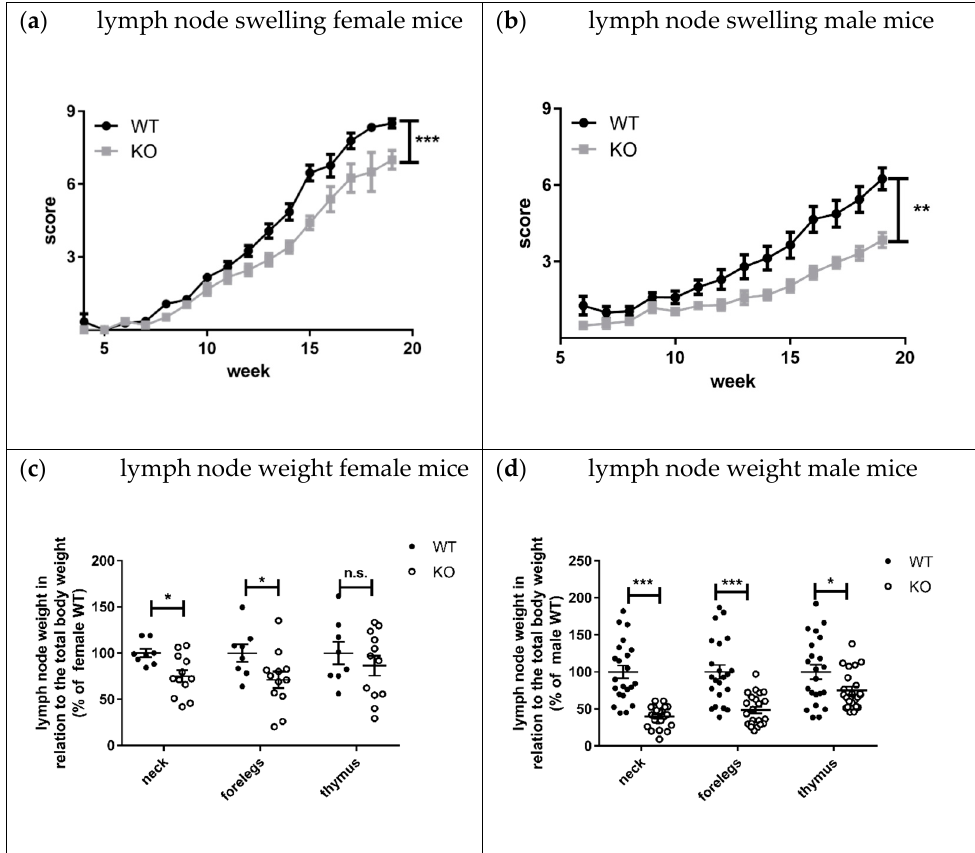
Figure 7. Lymph node swelling of female and male MRL-Fas lpr KSRP − / − mice compared to the MRL-Fas lpr KSRP +/+ animals during the course of the disease. ( a , b ) Data presented are the mean values ± SEM of the lymph node swelling of MRL-FAS lpr KSRP +/+ (WT) and MRL-FAS lpr KSRP − / − (KO). ( a ) 27 ‒ 30 females and ( b ) 25 ‒ 26 males (**: p < 0.01; ***: p < 0.001 compared to WT, two-way ANOVA). ( c , d ) The lymph nodes from the neck, front legs, and thymus of female and male 19-week-old MRL-FAS lpr KSRP +/+ and MRL-FAS lpr KSRP − / − were weighed and set in relation to the total body weight. Shown are the mean values ± SEM of the relative organ weights in relation to the WT animals (100%) of 8 to 12 animals per genotype ( c ) and 19 to 21 per genotype ( d ) (*: p < 0.05; n.s.: not significantly different from WT, t -test).